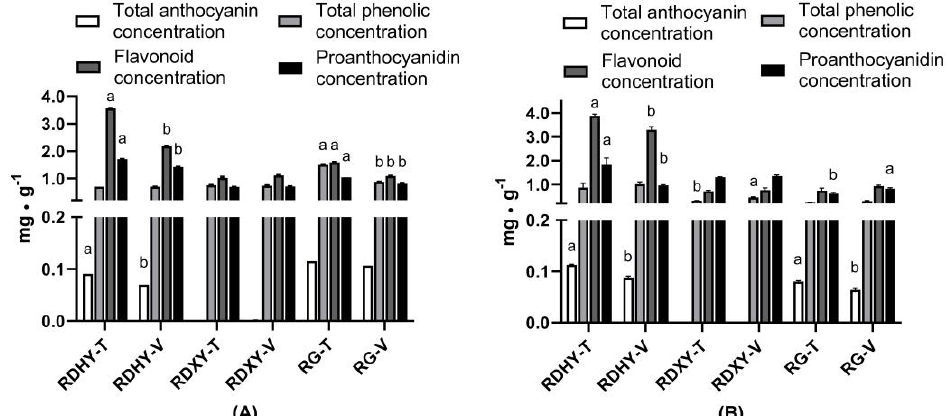
Figure 2. Effects of trellis systems on berry total anthocyanin concentration, total phenolic concentration, flavonoid concentration and proanthocyanidin in three table grape cultivars. ( A ) Year 2020, ( B ) Year 2021. For a certain cultivar, different letters above bars with the same color represent significant differences between treatments ( p value < 0.05). RDXY is a white grape cultivar whose total anthocyanin concentration is not applicable. Note: RDHY, ‘RuiduHongyu’; RDXY, ‘RuiduXiangyu’; RG, ‘Red Globe’; T, the T trellis system; V, the V trellis system.